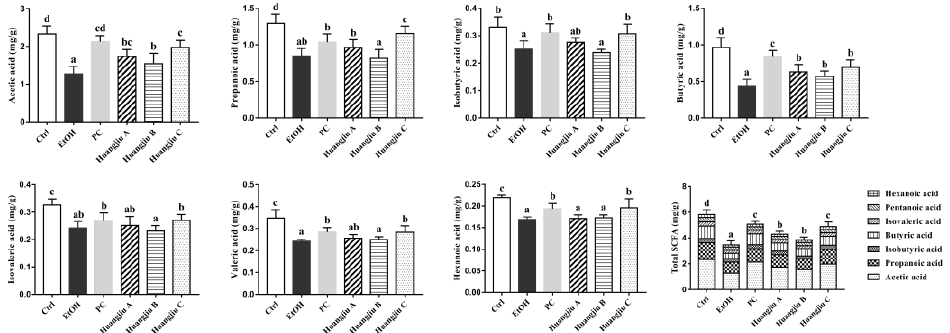
Figure 7. Effects of Huangjiu interventions on the levels of fecal short-chain fatty acids (SCFAs). Data expressed as mean ± standard deviation (SD) ( n = 10). Different lowercase letters indicate statistically significant differences ( p < 0.05) between the groups using one-way ANOVA followed by Fisher’s LSD test.